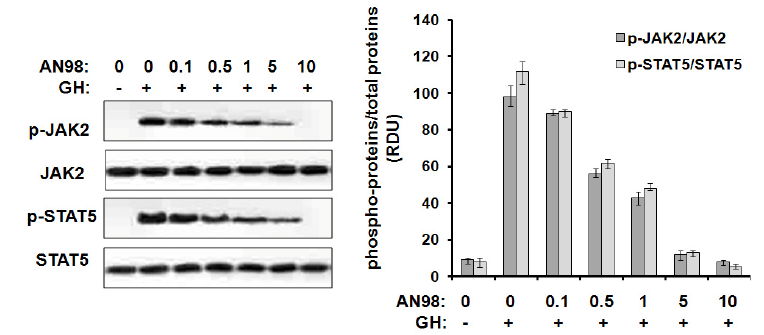
Figure 4. Inhibition of pGH-induced signaling by AN98 in CHO-GHR cells. The CHO-pGHR cells were cultured in serum starvation media for 10 h. A constant amount of pGH (100 ng) was pre-incubated with different concentrations of AN98, then the mixtures were added to the plates for 25 min at 37°C. After incubation, cell extracts were harvested, and samples (30 μ g of protein per lane) were subjected to SDS–PAGE (10% gel) and transferred to a PVDF membrane. After blocking the membrane with 5% non-fat milk, the membrane was probed with phospho-JAK2 phospho-STAT5 antibodies according to the manufacturer’s protocols. The membrane was then washed and incubated with secondary antibody conjugated to HRP for 2 h. After three washes with PBST, protein bands were detected using the ECL system. The figures represent at least three independent experiments. pGH, porcine growth hormone; GHR, growth hormone receptors; SDS–PAGE, sodium dodecyl sulfate-polyacrylamide gel electrophoresis; PVDF, polyvinylidene fluoride; JAK2, janus kinase 2; STAT5, signal transduction and activator of transcription; HRP, horseradish peroxidase; ECL, enhanced